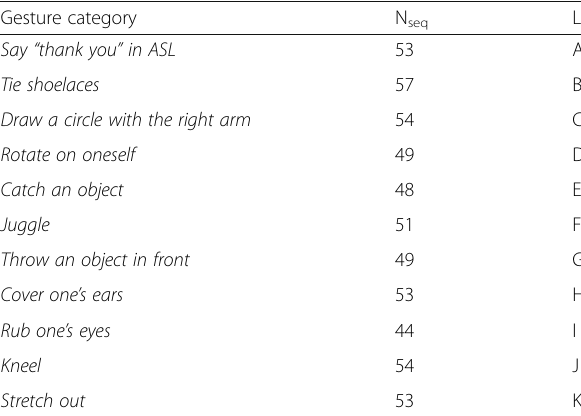
Table 1 Gesture categories, number of sequences per class and symbolic labels